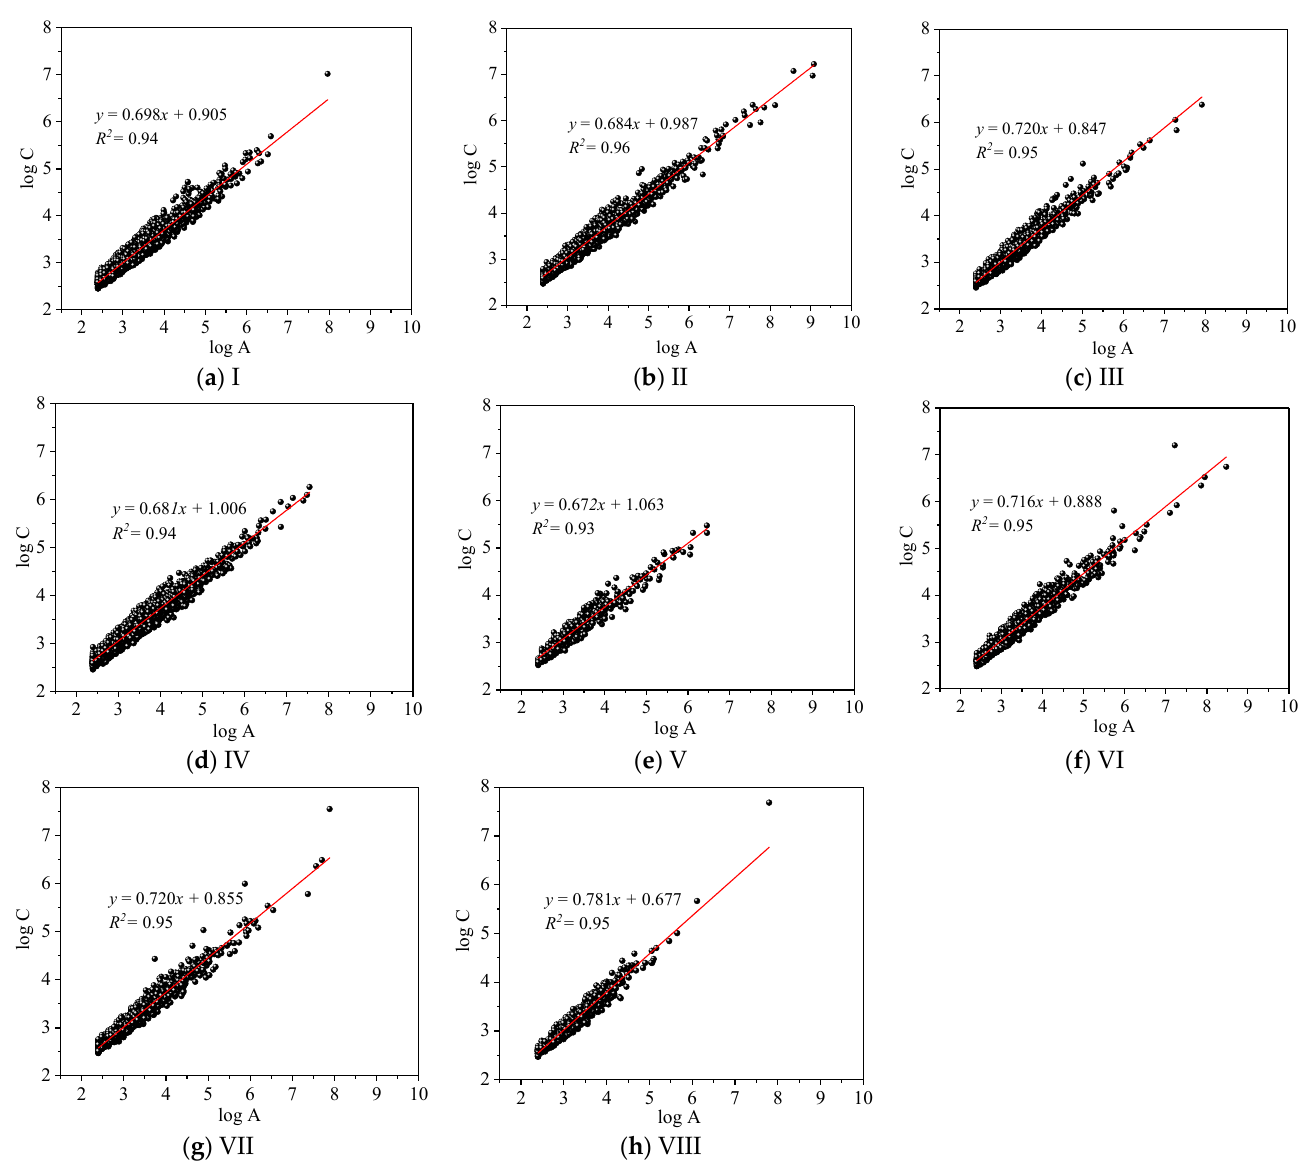
Figure 3. Calculated from log(C) vs. log(A) of SEM analysis: ( a ) Sample I; ( b ) Sample II; ( c ) Sample III; ( d ) Sample IV; ( e ) Sample V; ( f ) Sample VI; ( g ) Sample VII; ( h ) Sample VIII.